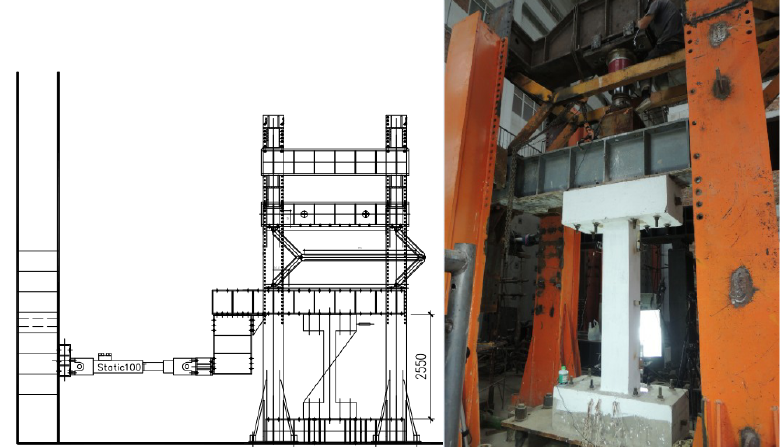
Figure 11. Test setup of the eight RC columns.